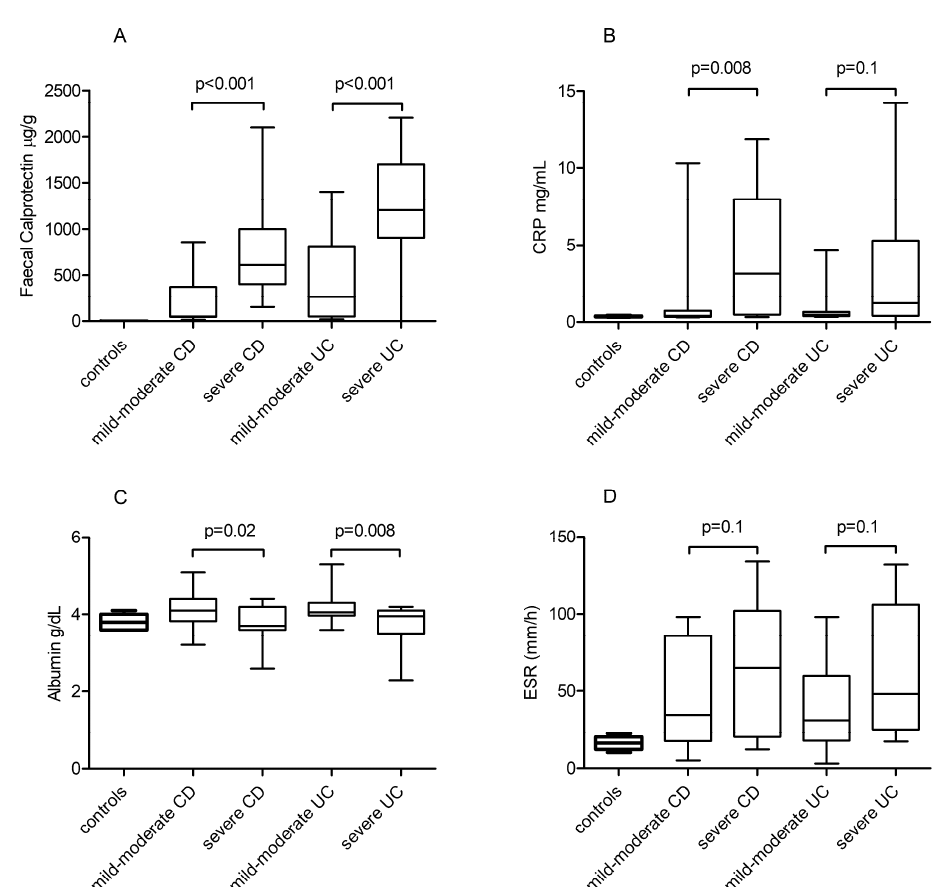
Figure 1. Standard inflammatory biomarker distributions in IBD patients according to disease severity: ( A ) FCal levels in mild-moderate vs. severe CD and mild-moderate vs. severe UC groups. ( B ) CRP serum levels in mild-moderate vs. severe CD and mild-moderate vs. severe UC groups. ( C ) Albumin serum levels in mild-moderate vs. severe CD and mild-moderate vs. severe UC groups. ( D ) ESR serum levels in mild-moderate vs. severe CD and mild-moderate vs. severe UC groups. Biomarker levels in controls are also shown.